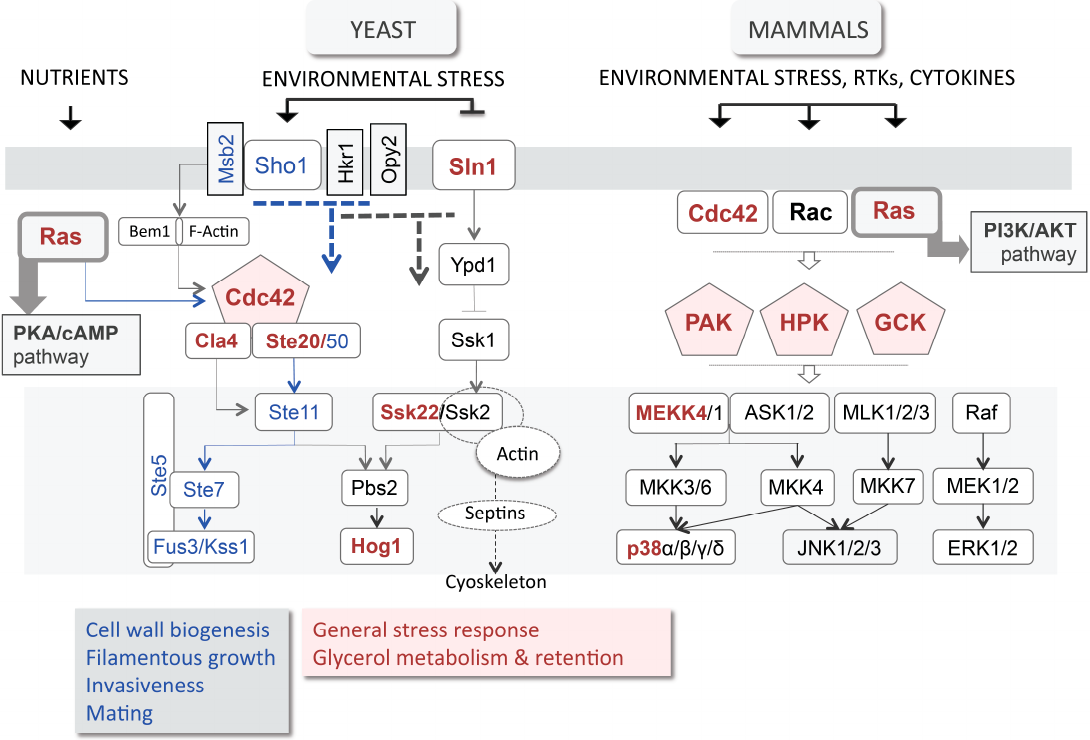
Figure 2. Parallelism between MAPK signalling cascades in yeast and in mammalian cells. In bold: proteins that functionally complement yeast mutants. In orange: proteins that are identical in yeast and mammalian pathways. In blue: proteins involved in the yeast phenotypes affected by GUP1 deletion. Pentagons refer to nodal proteins exerting multiple signalling, affecting positive or negatively many other proteins ( star-type pathway). Required nomenclature disambiguation: PAK: P21 Activated Kinase; HPK: Histidine Protein Kinase (Sln1 is also a histidine-aspartate phosphotransferase/kinase); GCK: Germinal Center Kinase; MEKK4 = MTK1. The strains without GUP1 are unable to grow under high osmotic stress [19,28]. This could indicate a malfunction of the HOG pathway and a concomitant deficient production and/or